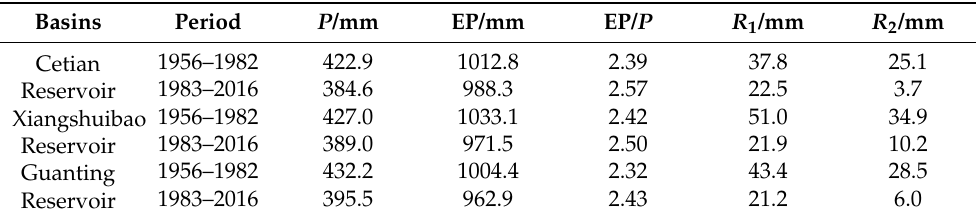
Table 2. Annual mean values of meteorological and hydrological elements in the basins of Yongding River mountain area in different